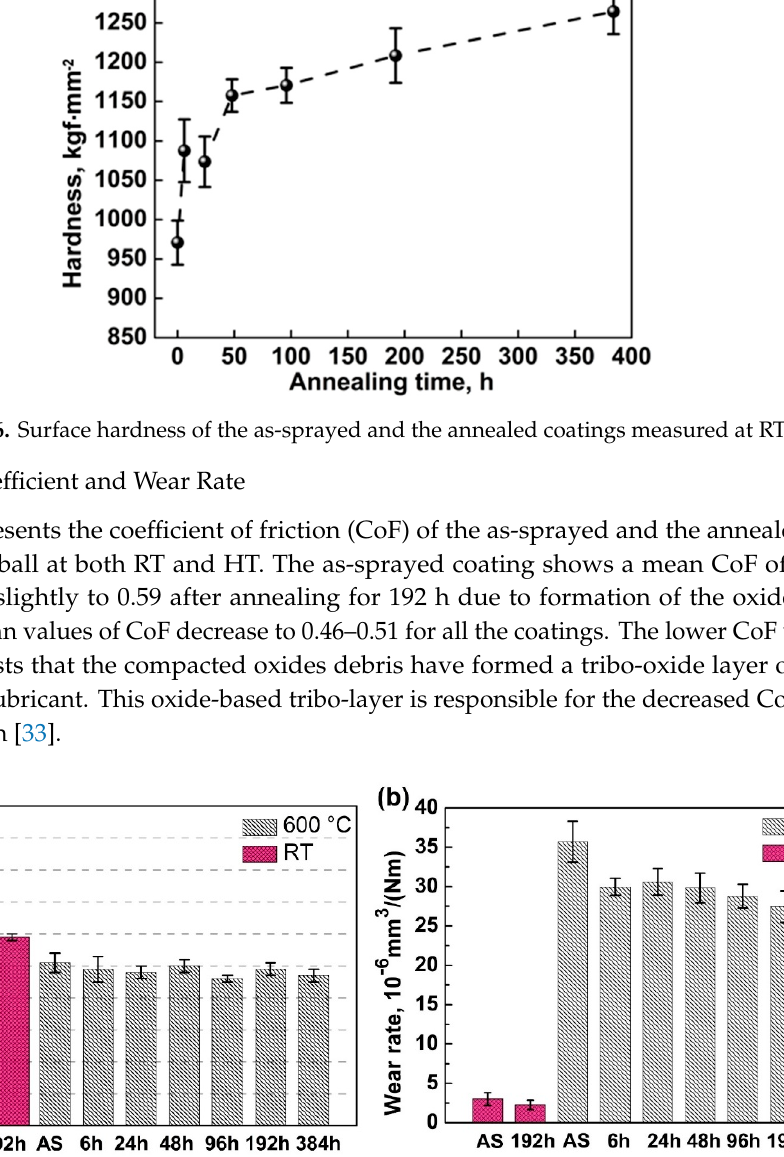
Figure 7. ( a ) COF and ( b ) wear rate of the as-sprayed and the annealed coatings versus Si 3 N 4 at RT and at 600 °C. AS stands for as-sprayed coating without heat treatment.